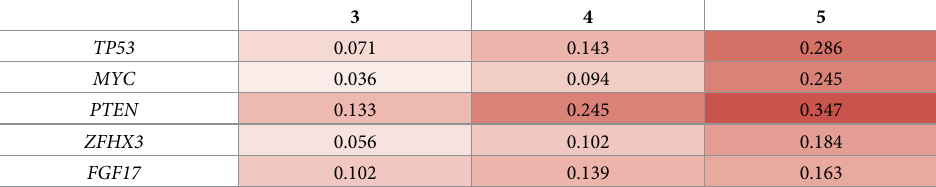
Table 9. Probabilities of source aberration with downstream target for prostate cancer subtypes. For primary glea- son grade subtypes of prostate cancer, the heatmap represents the probabilities that the indicated gene is a DNA-aber- rant source gene with some downstream RNA-aberrant target. The sources are selected from the set of core genes for coverings of the given tissue; the selection criterion is that the probability of a DNA-aberration is high for at least one of the subtypes for that tissue.